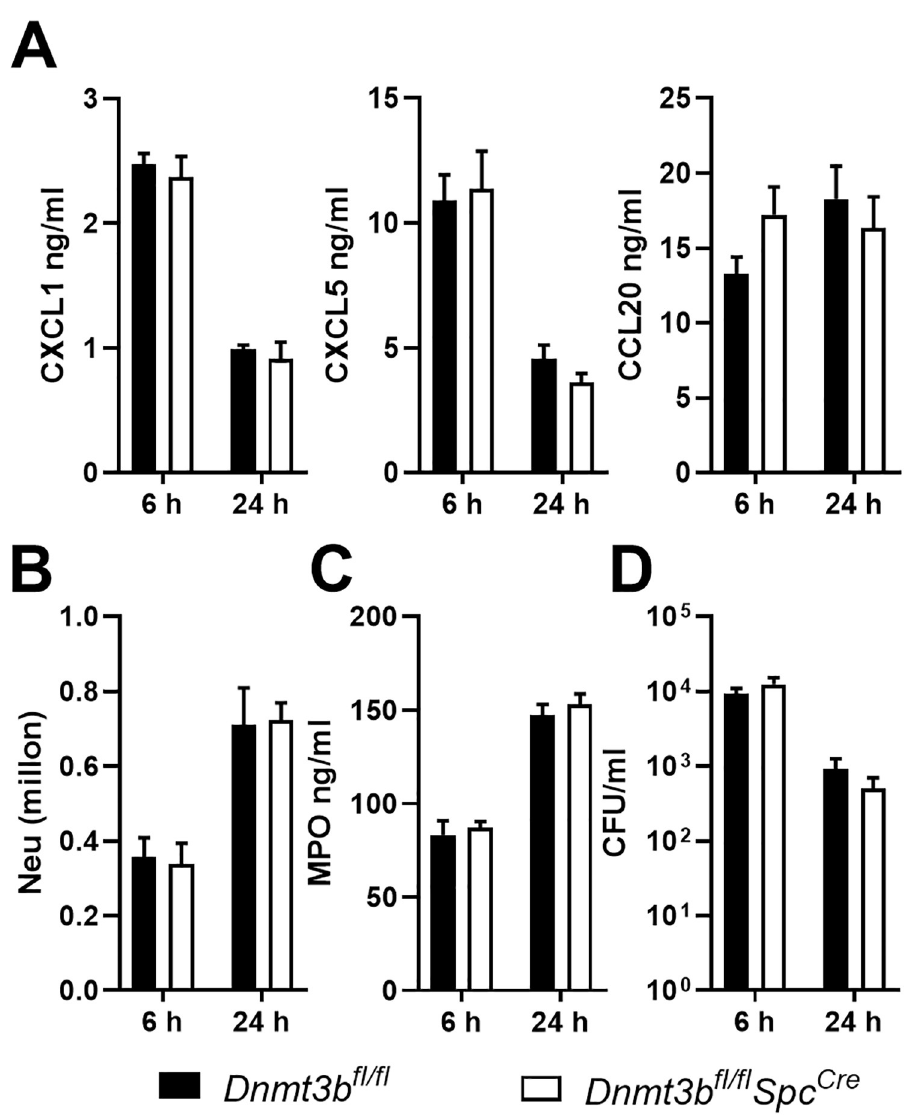
Fig 6. Type II alveolar epithelial cell Dnmt3b has no role in the pulmonary response during Pseudomonas pneumonia in vivo . Dnmt3b fl/fl SpC Cre and control Dnmt3b fl/fl mice were infected with PAK (5 x 10 6 CFU) intranasally. CXCL1, CXCL5 and CCL20 were determined in BALF harvested after 6 or 24 hours (A). Neutrophil counts (B), MPO (C) and bacterial counts (D) in BALF were determined. Data are presented as means ± SEM of 8 mice per group at each time